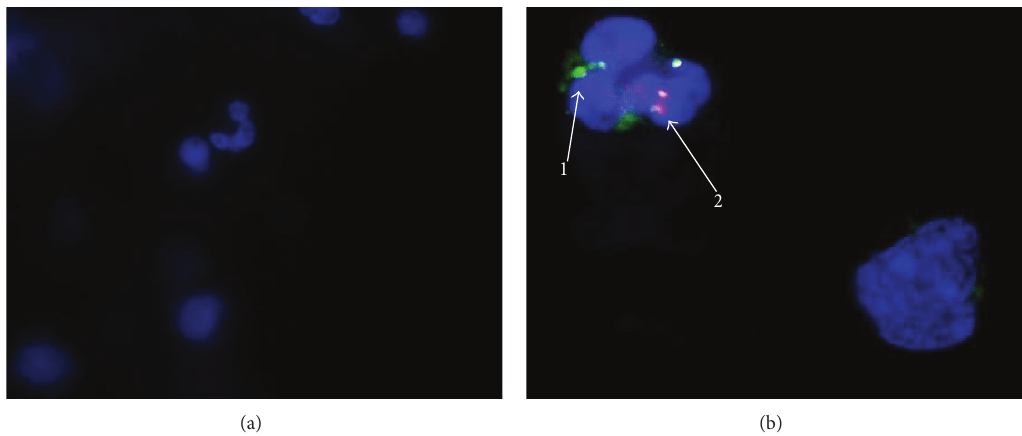
Figure 5: Fluorescent microscopic images of neutrophils obtained using an integrated digital camera. (a): DAPI staining of neutrophils (40x oil immersion). (b): DAPI staining of neutrophils, FITC stained H37Rv colocalizing with the lysotracker-labeled acidified compartment (100x oil immersion). Label 1 represents green fluorescent-labeled H37Rv in nonacidified phagosomal compartment. Label 2 represents colocalization of green fluorescent-labeled H37Rv with lysotracker, indicating acidification of H37Rv-containing